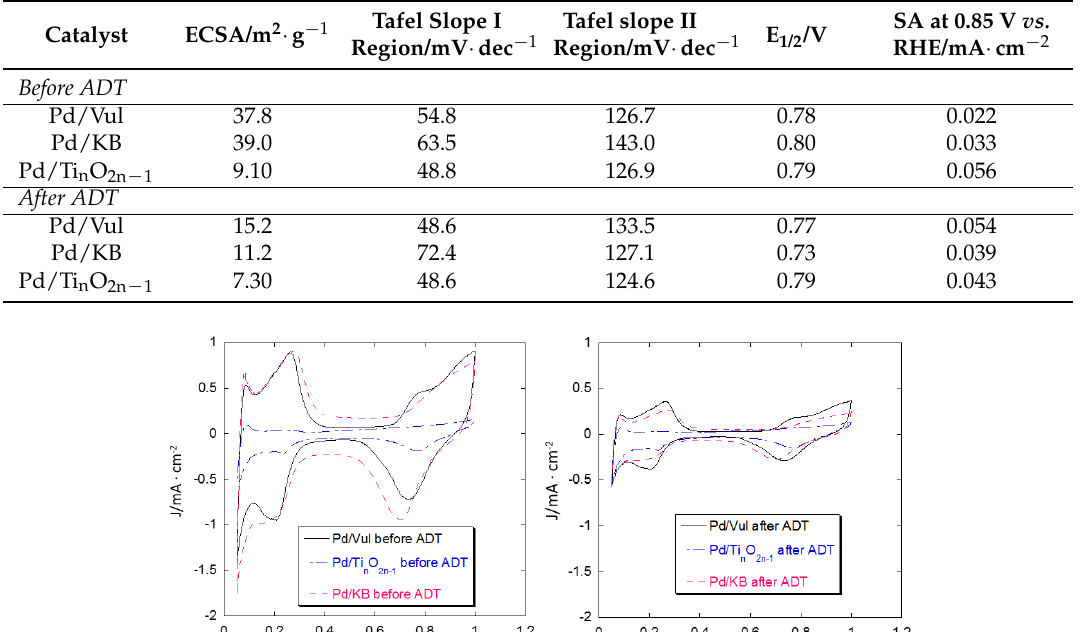
Table 1. Kinetic parameters for the Pd/support catalysts.